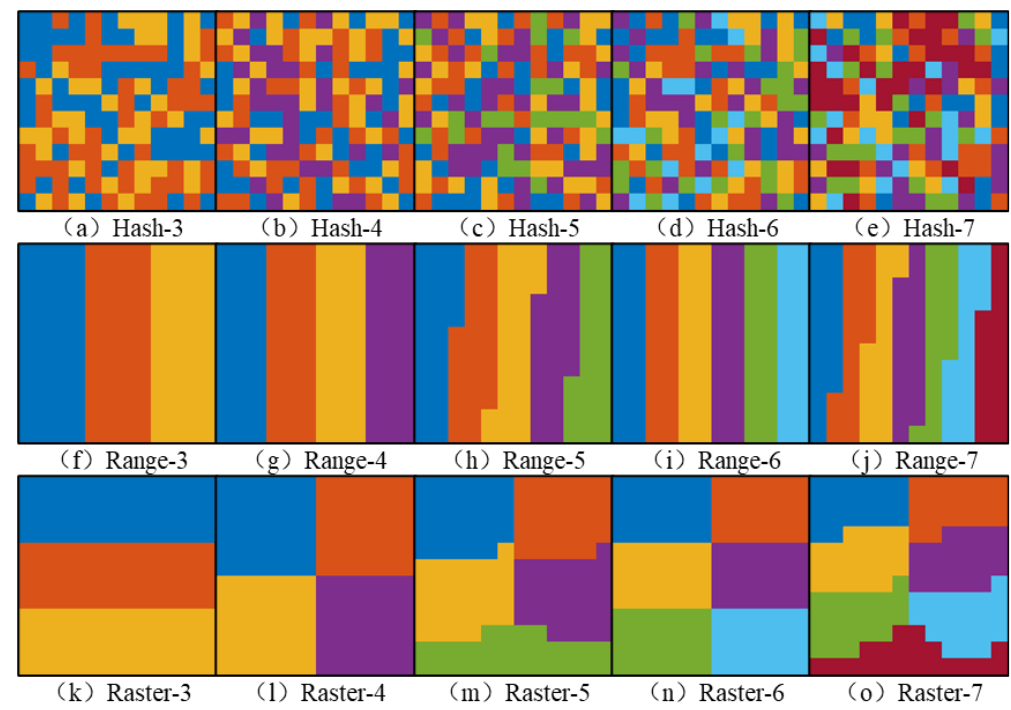
Figure 13. The partition results for the hash, range and raster partition methods over the 12 × 12- image layout.